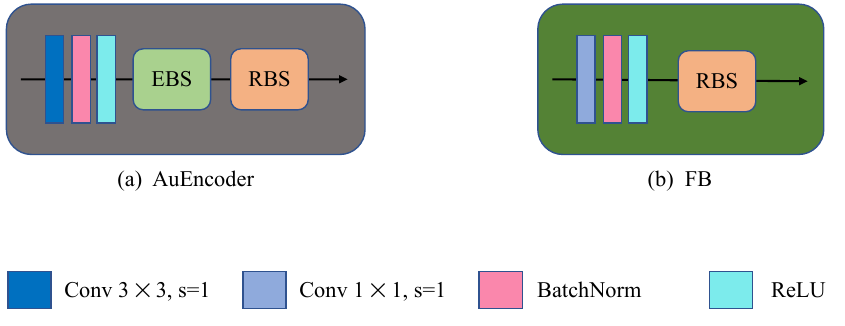
Figure 7. Architectures of ( a ) AuEncoder, ( b )